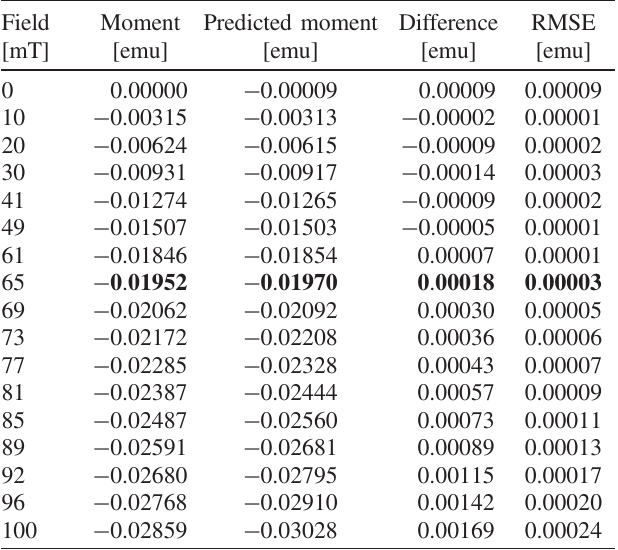
TABLE I. Data taken from the hysteresis curve shown in Fig. 2. The RMSE begins a continuous increase at 65 mT (H indicating that flux has already entered the sample at that field.